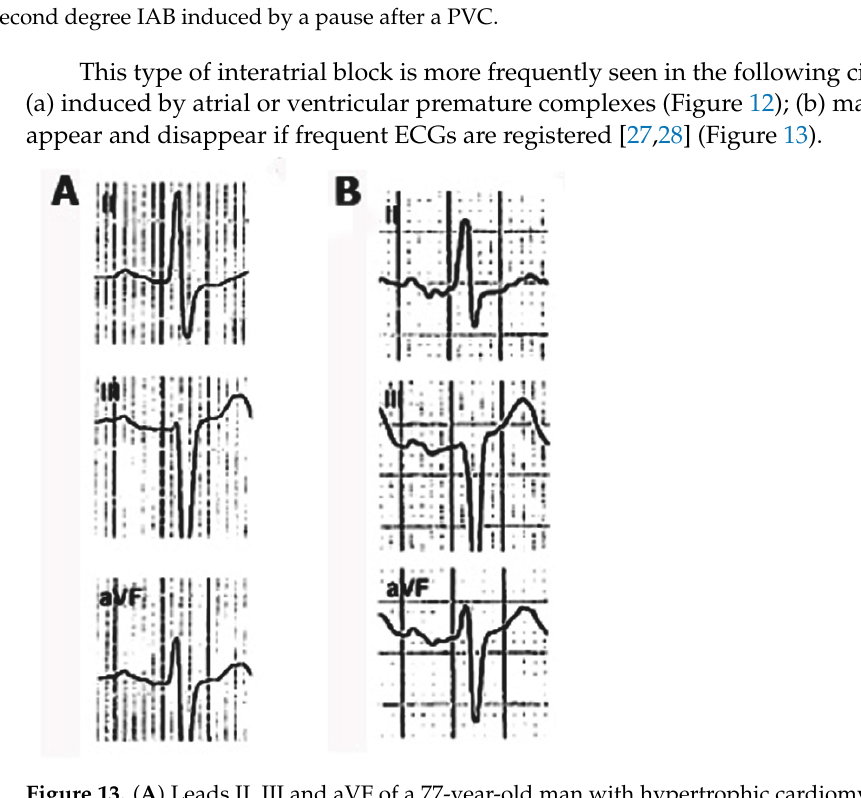
Figure 13. ( A ) Leads II, III and aVF of a 77-year-old man with hypertrophic cardiomyo- pathy. Heart rate 70 bpm: P-wave 160 ms (partial IAB). ( B ) Same patient was hospitalized